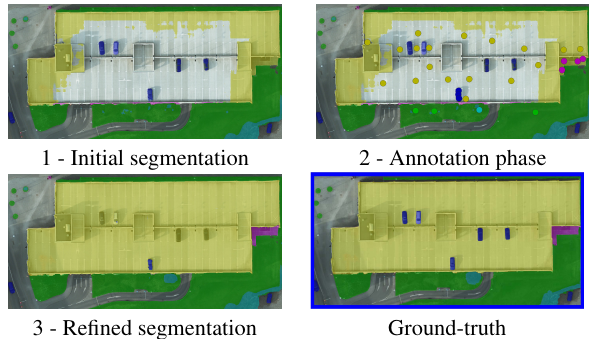
Figure 10. Difficult segmentation of an outside parking since the network has not learned the semantic cars on building . Only the car at the bottom is annotated and